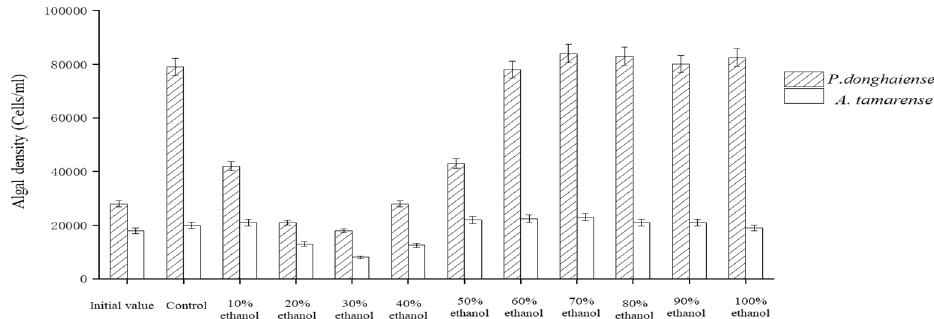
Figure 6. Algae inhibition by gradient elution of macroporous resin with